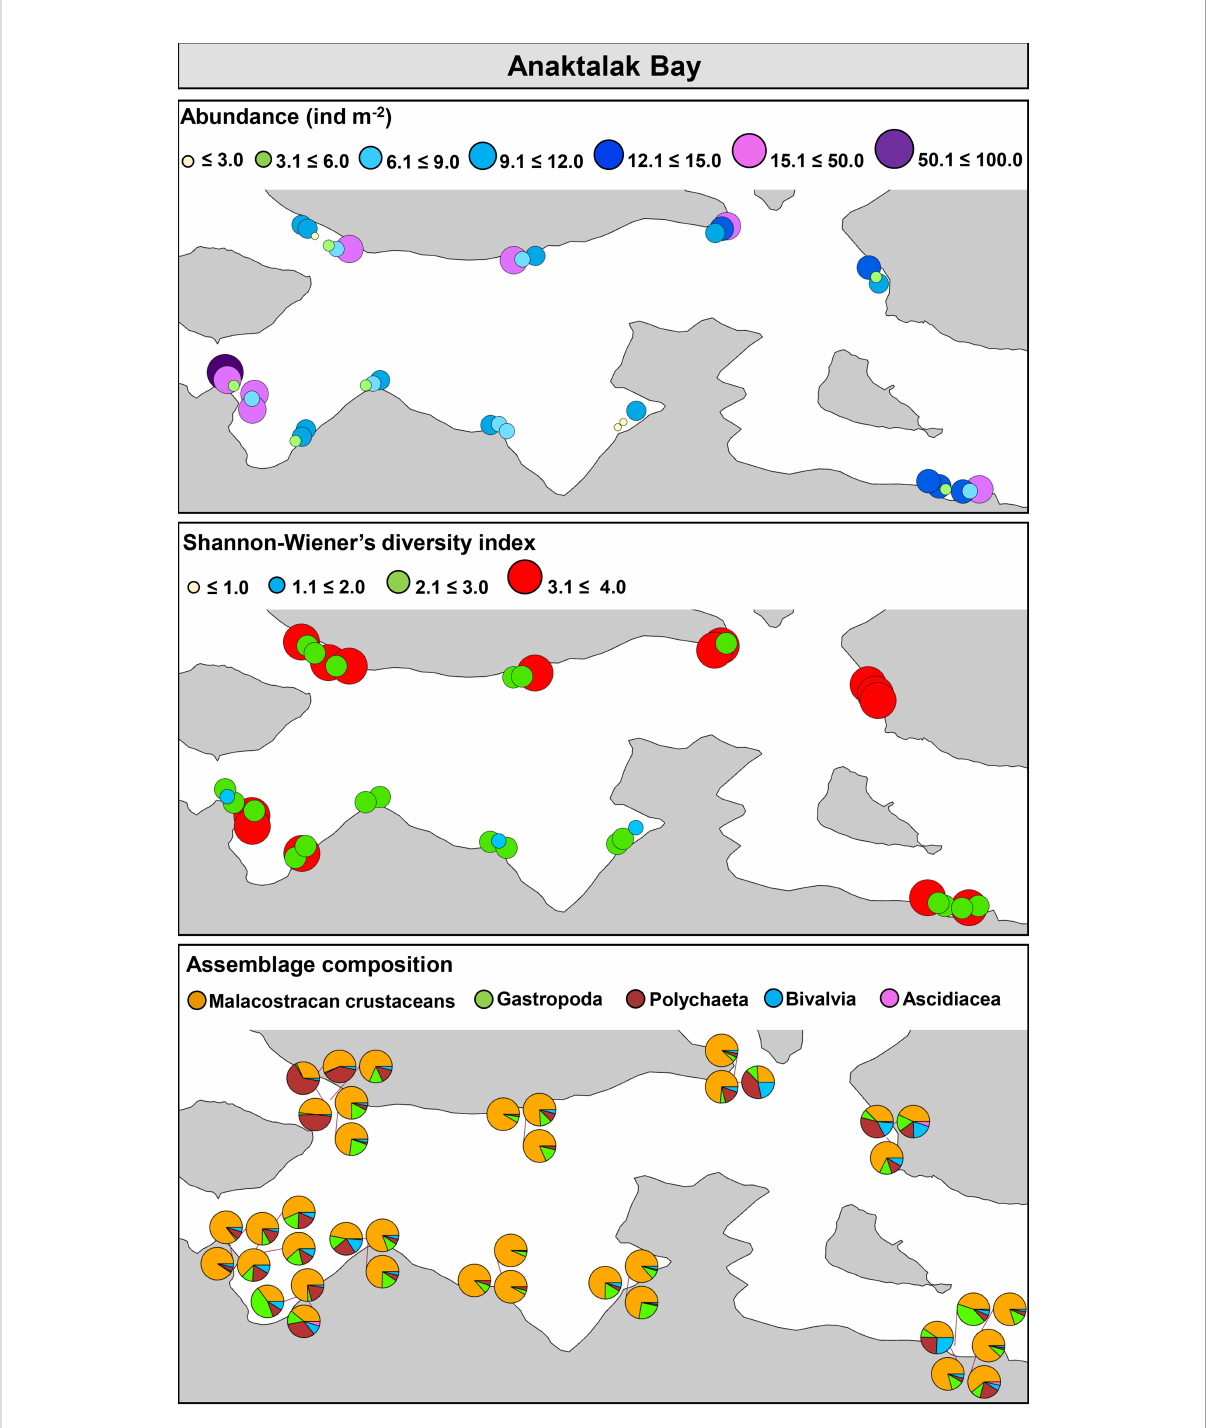
FIGURE 5 Community metrics and assemblage composition in Anaktalak Bay,